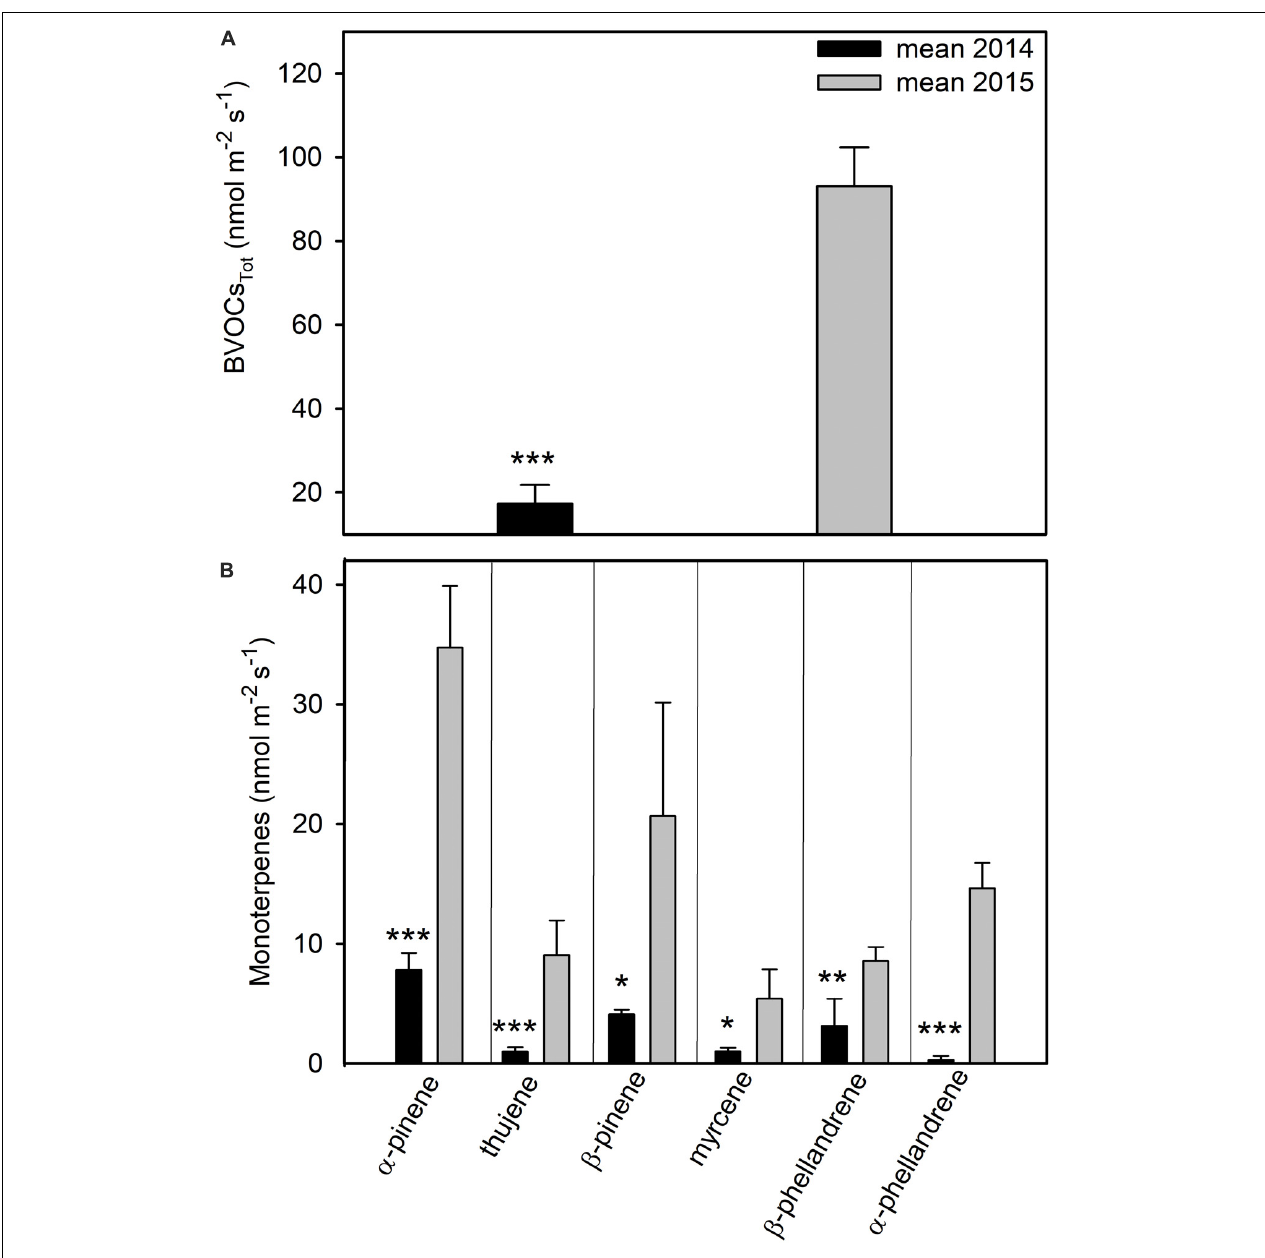
FIGURE 7 | Total biogenic volatile organic compound emission (BVOC Tot ) (A) and monoterpenes emitted (B) by C. incanus leaves in July 2014 and 2015. Data are means ± SD ( n = 8). Asterisks represent differences between the two years, *( p ≤ 0.05), **( p ≤ 0.01), ***( p ≤ 0.001) based on t